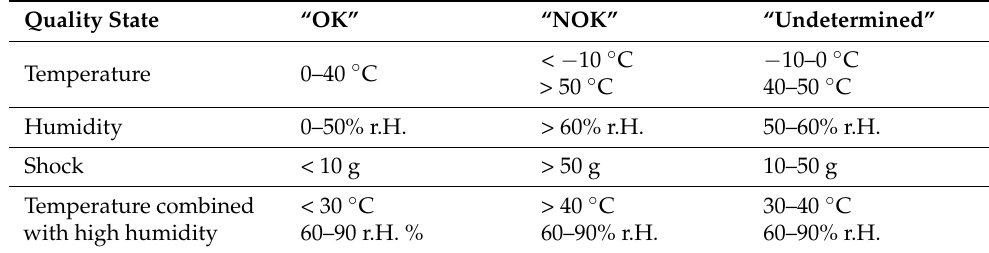
Table 2. Threshold table derived from product datasheets. Legend: ◦ C: Degree Celsius as unit of measurement (UOM) for temperature; g: multiples of the earth gravitation (g = 9.81 N/kg) as UOM for shock; r.H.: relative Humidity of the air, in